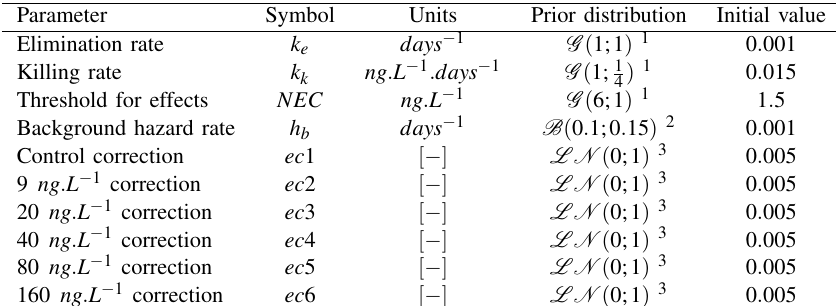
S URVIVAL MODEL PARAMETERS INFERENCE